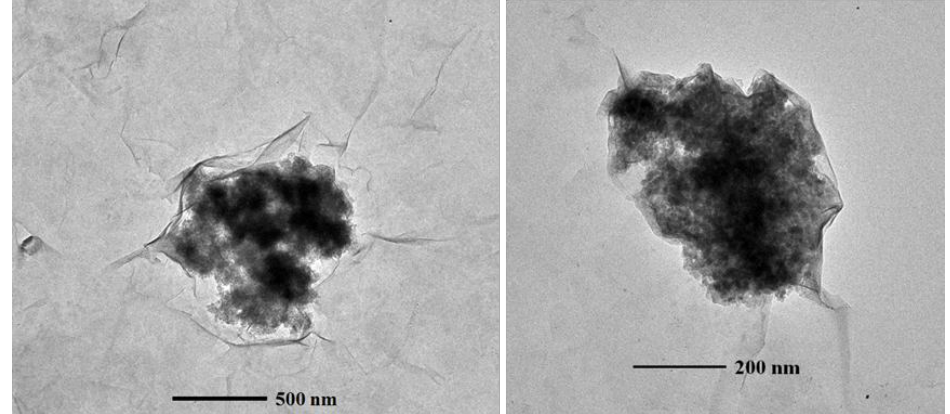
Figure 7. Bright field TEM images of 10 nm γ-Al 2 O 3 NPs with montmorillonite at PZC of Al 2 O 3 NPs. Nanomaterials 2016 , 6 , 90 10 of 15